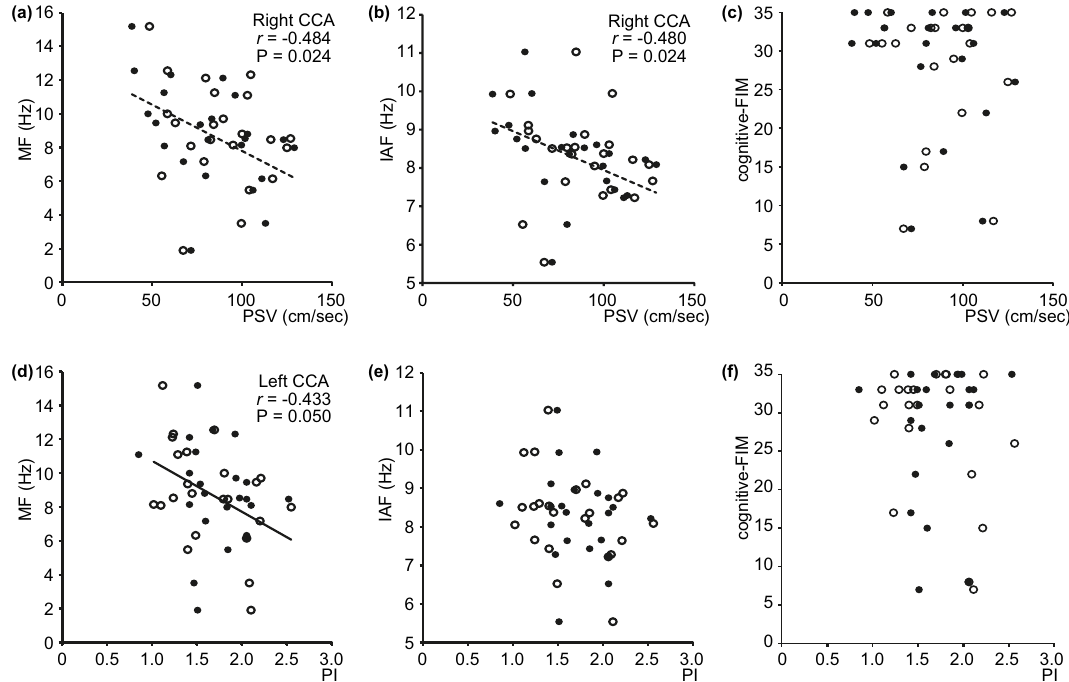
Figure 2. Scatterplots visualising the relationship between the ultrasonographic parameters [( a – c ), PSV; and ( d – f ), PI] in either side of the CCA and the MEG spectral parameters and cognitive-FIM score [( a , d ), MF; ( b , e ), IAF; and ( c , f ), cognitive-FIM]. Regression lines are added where there is a significant correlation between the parameters (bootstrapping statistics after FDR correction). Open dot, left CCA; filled dot, right CCA; solid regression line, left CCA; broken regression line, right CCA. Biases in terms of patient age and sex were not considered. CCA common carotid arteries, FDR false discovery rate, FIM functional independent measure, IAF individual alpha frequency, MEG magnetoencephalography, MF median frequency, PI pulsatility index, PSV peak systolic flow